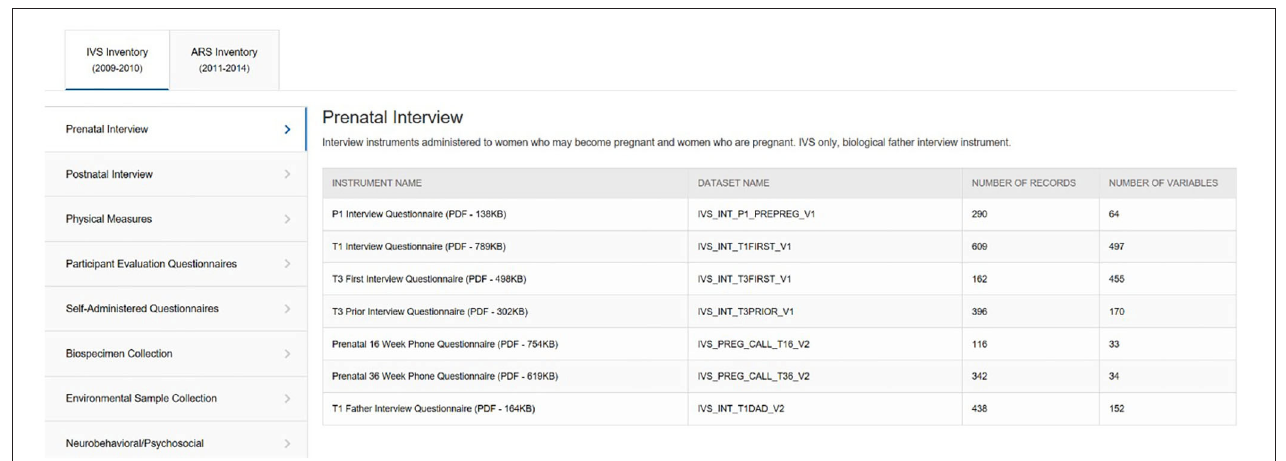
FIGURE 5 | NCS Archive Instrument